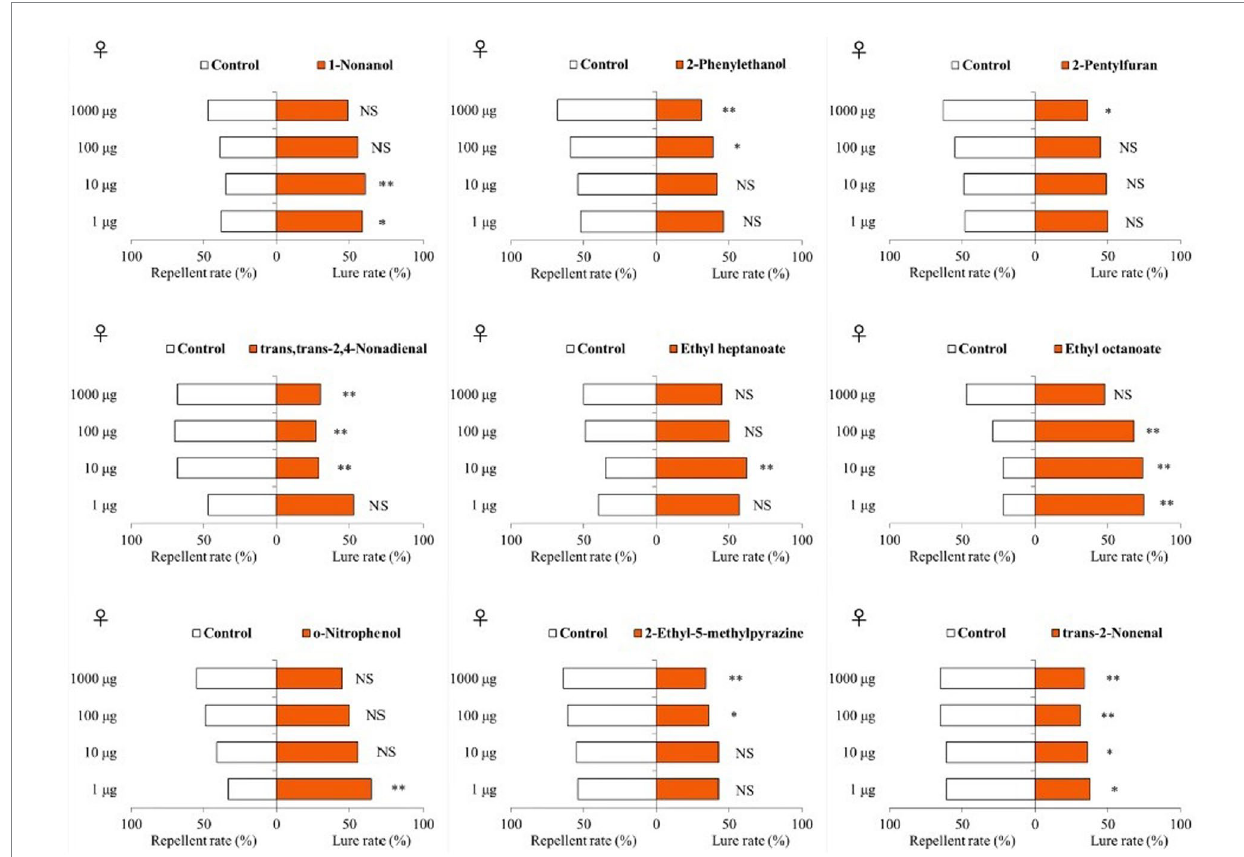
FIGURE 3 Responses of female T. absoluta to nine VOCs in a Y-tube olfactometer. NS indicates no significant difference; asterisks indicate significant differences (* p < 0.05; ** p <